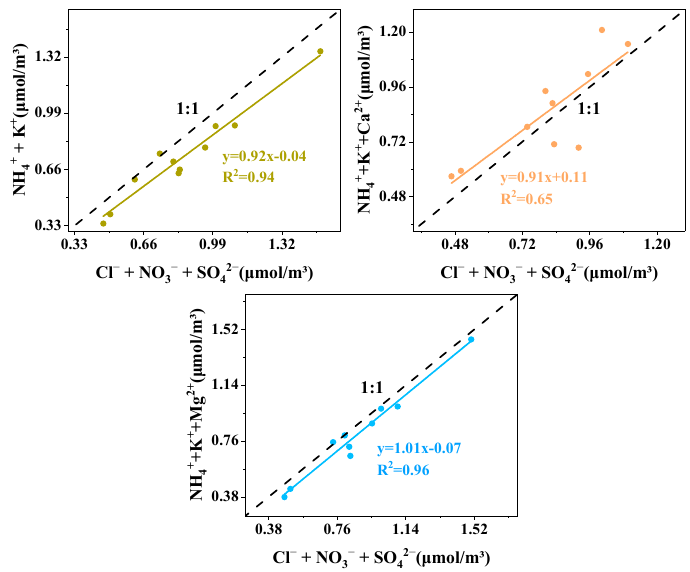
Figure 8. Scatter plot of some cations and Cl − + NO 3 − +SO 42 − .